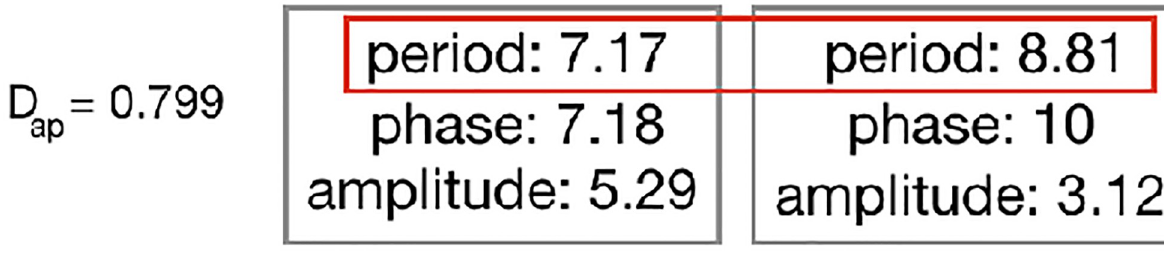
Fig 11. Example of